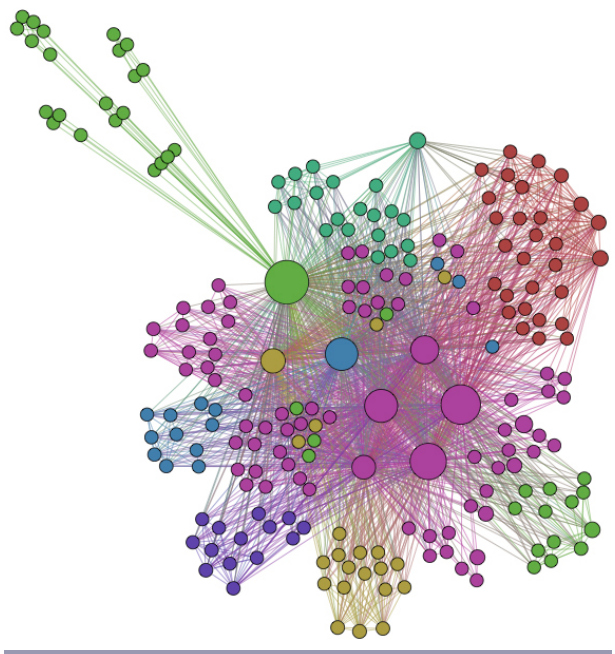
Fig. 4 . Network of individual plots. Colors represent communities defined through the modularity measure and node size represents eigenvector centrality.